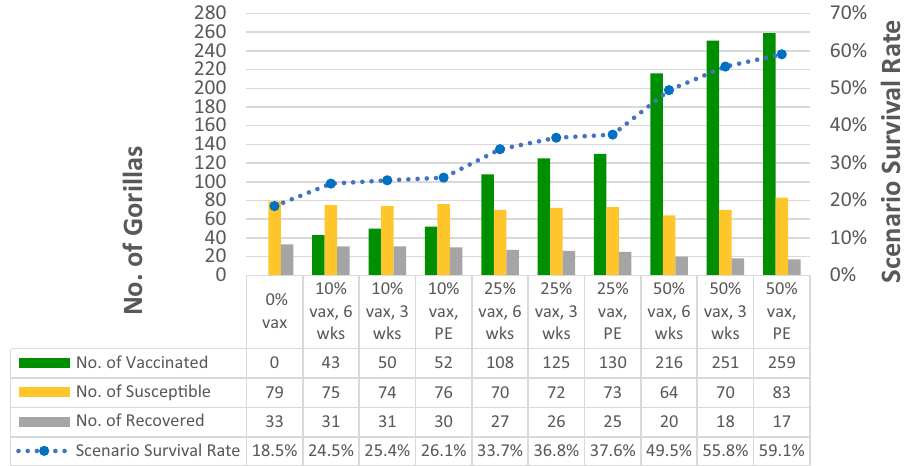
Figure 6. Mean end counts (the number of surviving individuals at the end of the year) by disease state listed in order of least survival to greatest survival for the various vaccination scenarios. This demonstrates that the pathogen sweeps through the population in every scenario. PE—preemptive; vax—vaccination of habituated